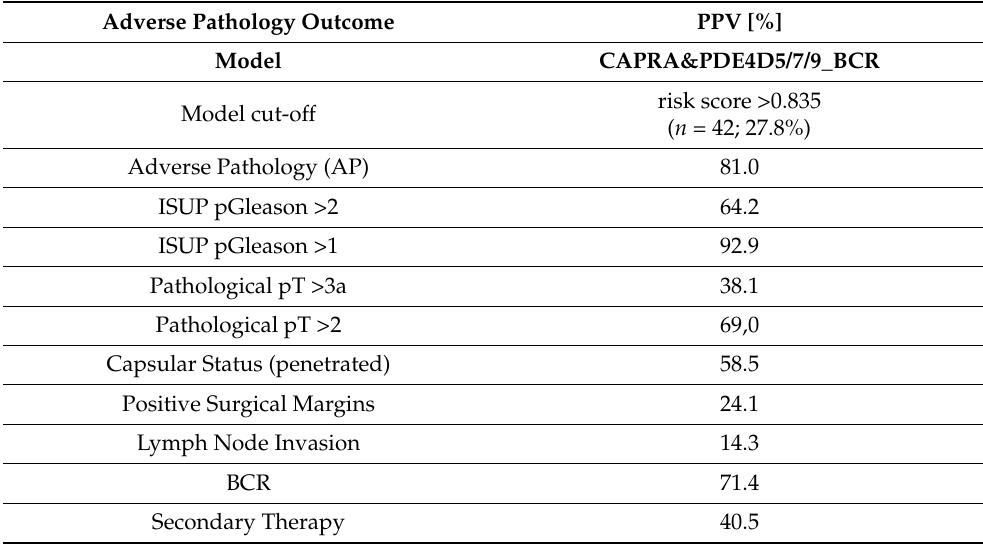
Table 7. Positive Predictive Value (NPV) of the CAPRA&PDE4D5/7/9_BCR model (entire cohort; n =